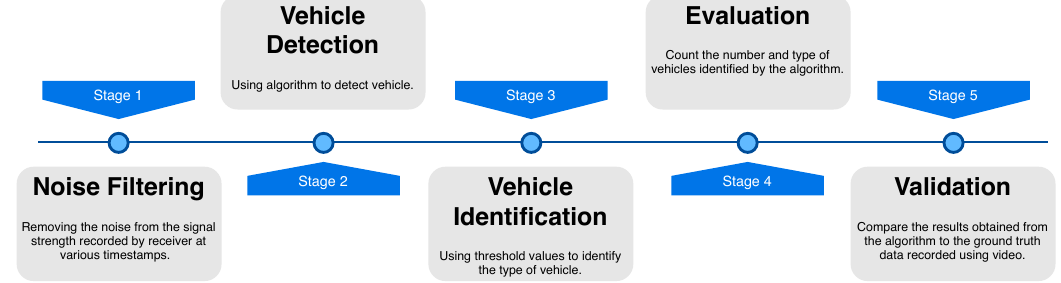
Figure 5. Overall flow of